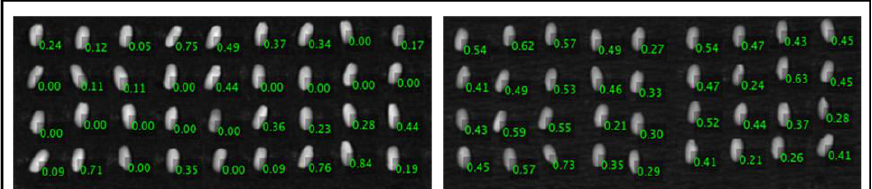
requirement in the extraction process. Hence, to justify the prediction on a single seed, the average anthocyanins content within each variety was calculated (Figure 5). The average value was compared to the reference value from HPLC and was followed by calculating the root mean square error (RMSE) to evaluate the prediction accuracy. Figure 4. A visualization of anthocyanins based on their concentration in rice powder ( A ) and seeds ( B ).